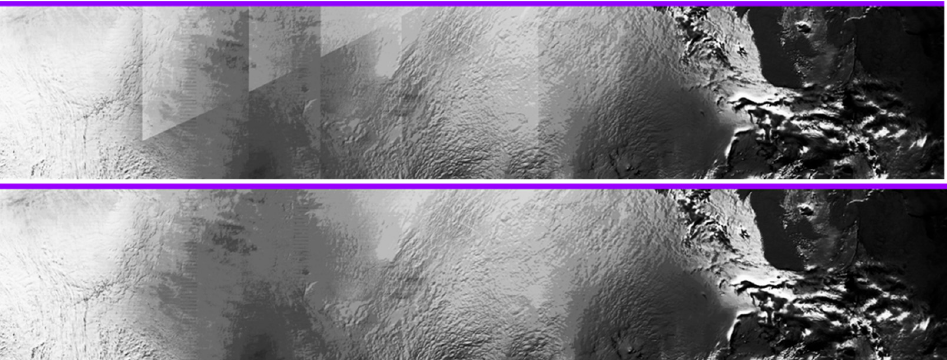
Figure 6. NCC Imagery granules from before ( top ) and after ( bottom ) the NCC banding anomaly code change fix. These images are greatly enhanced in order to emphasize the vertical discontinuities or jumps and one angular jump in the brightness that appear in this scene from 1 December 2020 over Antarctica, an otherwise fairly homogeneous and bright scene that allowed the banding to be initially discovered.